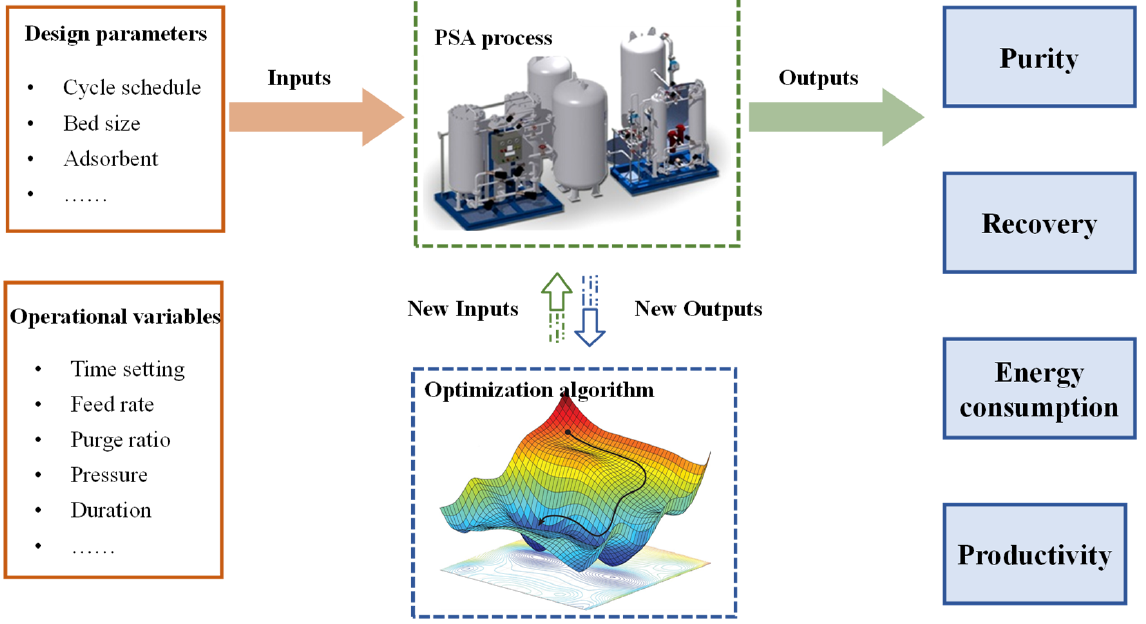
Figure 2. Typical PSA-process optimization